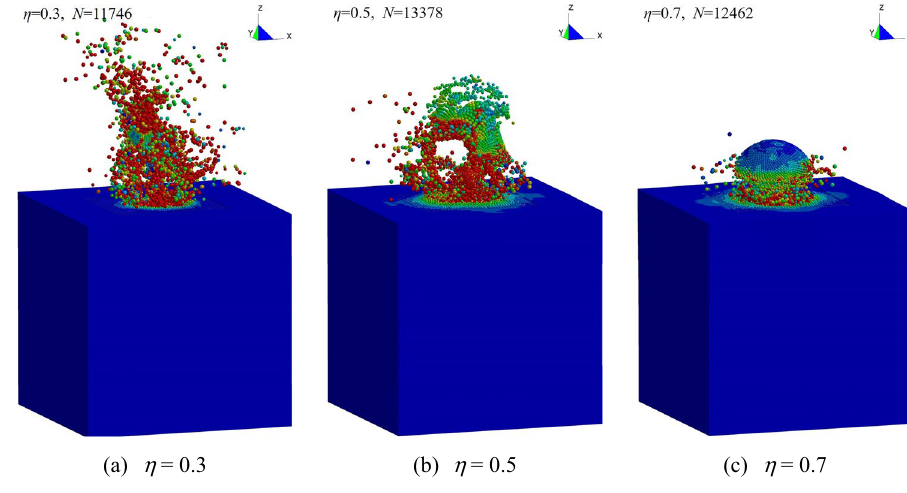
Fig. 18 The proportion of different upper stage charges. a η = 0.3; b η = 0.5; c η =